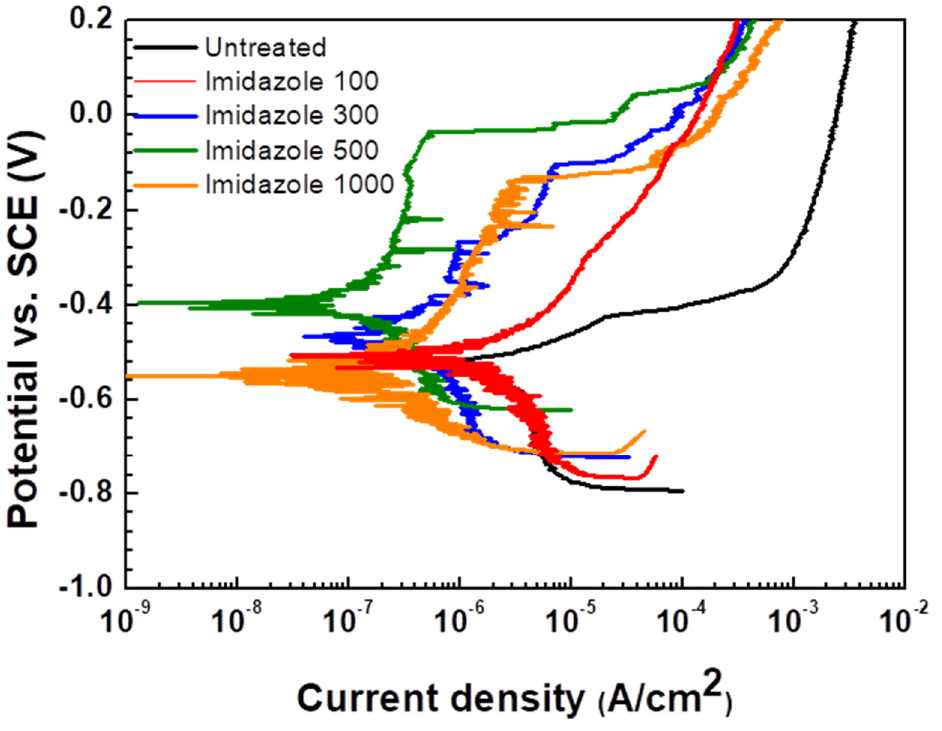
Figure 2. Potentiodynamic polarization curves of SPPS-38 carbon steel weldment as a function of imidazole concentration in the deaerated district heating water at 60 °C. Table 2. Parameters extracted from the potentiodynamic polarization curves of SPPS-38 carbon